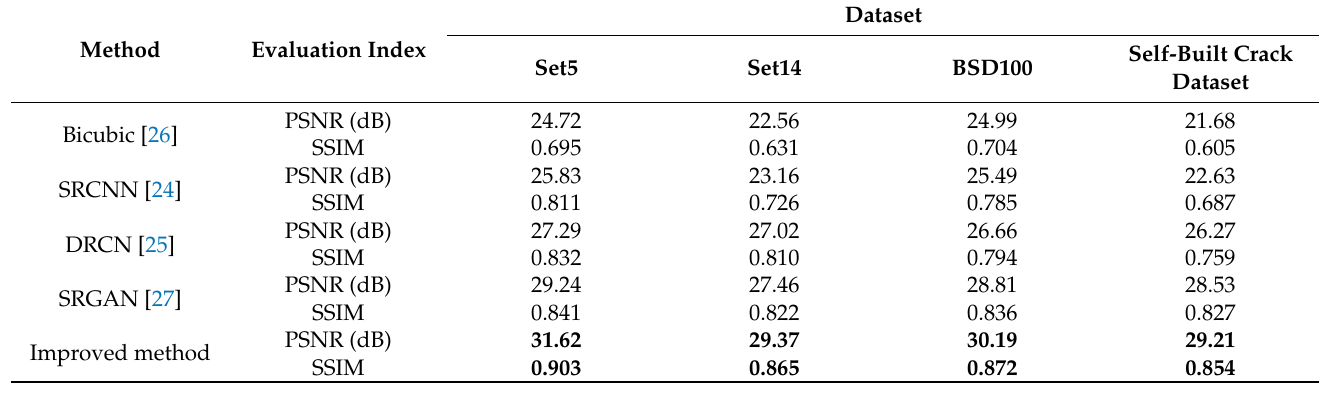
Table 4. PSNR and SSIM comparison on different data sets.